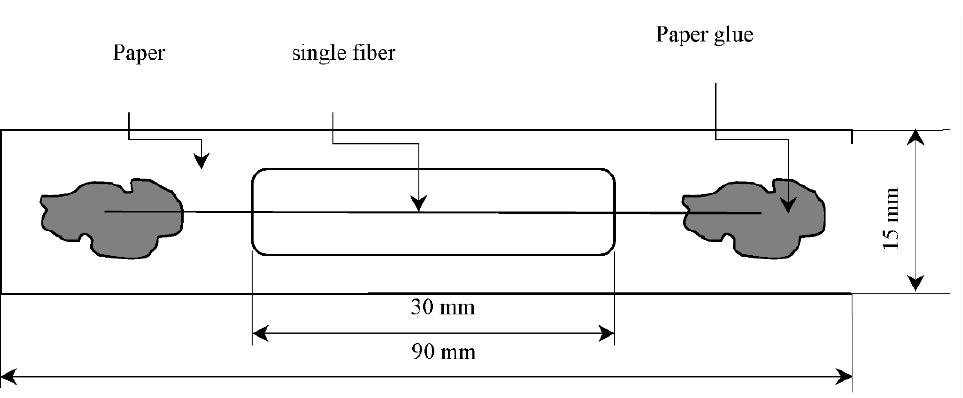
Figure 2. A tensile test specimen ASTM 3379-02.